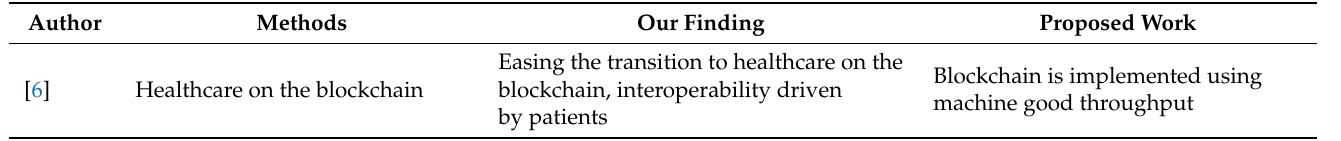
Table 1. Decentralized Industrial Internet of Things Security Using